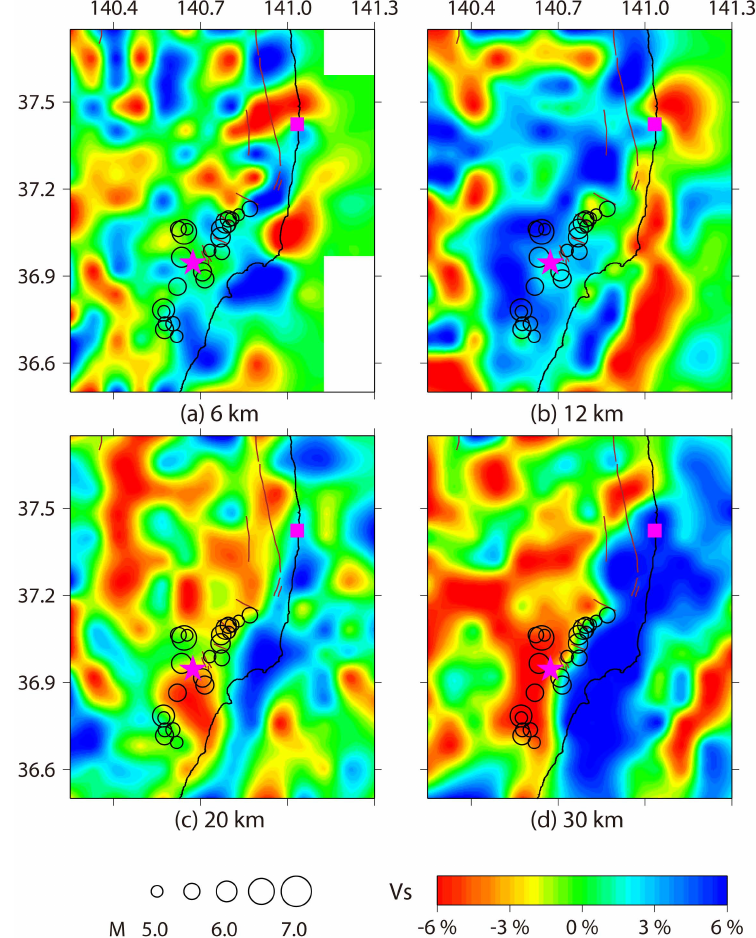
Fig. 4. The same as Fig. 3 but for the finite-frequency S-wave